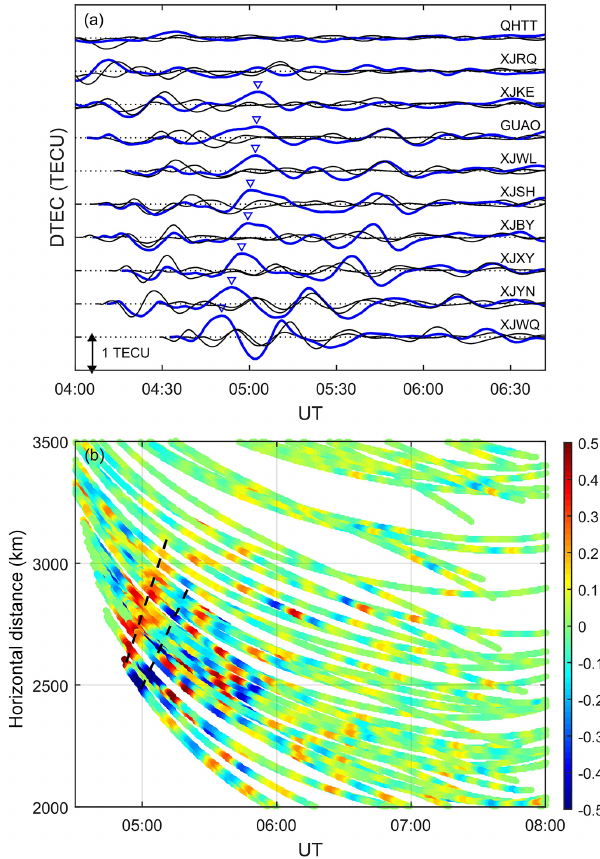
Figure 3. (a) Temporal and (b) spatial variations of the TEC per- turbations observed by the GPS stations in northwest China on 15 February 2013. Panel (a) shows the series from 10 selected sta- tions whose locations are marked by red and blue dots in Fig. 1. The codes of the stations are marked near each series. Blue lines in panel (a) represent the TEC perturbation series on 15 February 2013 and black lines the time series prior to and after that date. Triangles in panel (b) indicate the maximum of the TID’s amplitude. Con- tours in panel (b) represent the amplitudes of the TEC perturbation inTECU units. The horizontal distance ( y axis) in panel (b) is the spherical distance between the blast site and the ionospheric TEC pierce points at an altitude of 350km. Dotted lines in panels (a– b) denote the phase fronts of the TID. All TEC perturbation series are from GPS satellite PRN